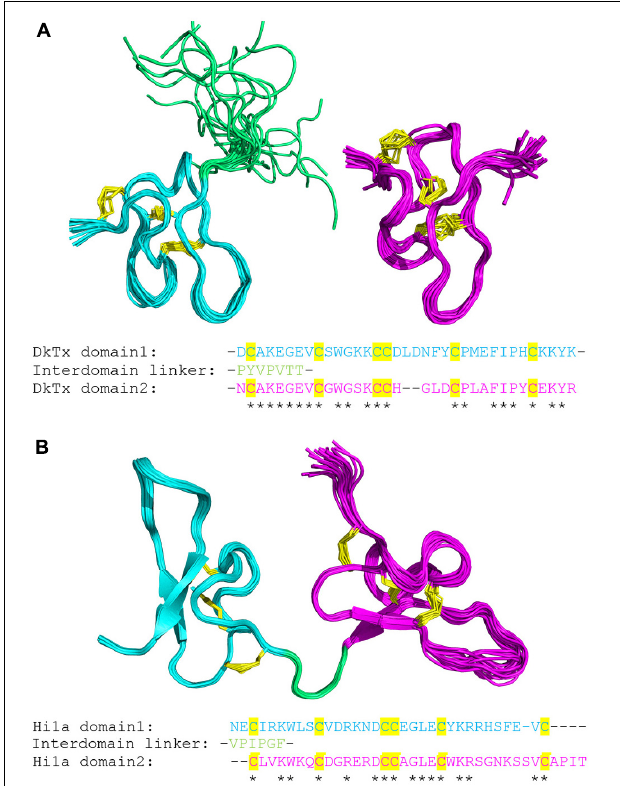
FIGURE 1 | 3D structure and domain alignment of ion-channel impairing SCREPs. (A) Solution structure of each individual domain of DkTx, with D1 (PDB-2N9Z) and D2 (PDB-2NAJ) in cyan and purple, respectively. The disulfide framework is highlighted in yellow, and the highly flexible linker region is shown in green. Below the structure is the primary sequence alignment of both domains, demonstrating the high level of homology between domains. (B) Solution structure of Hi1a (PDB-2N8F), highlighting each individual disulfide-rich domain connected by a more rigid peptide linker region. The aligned sequences of the individual domains are shown